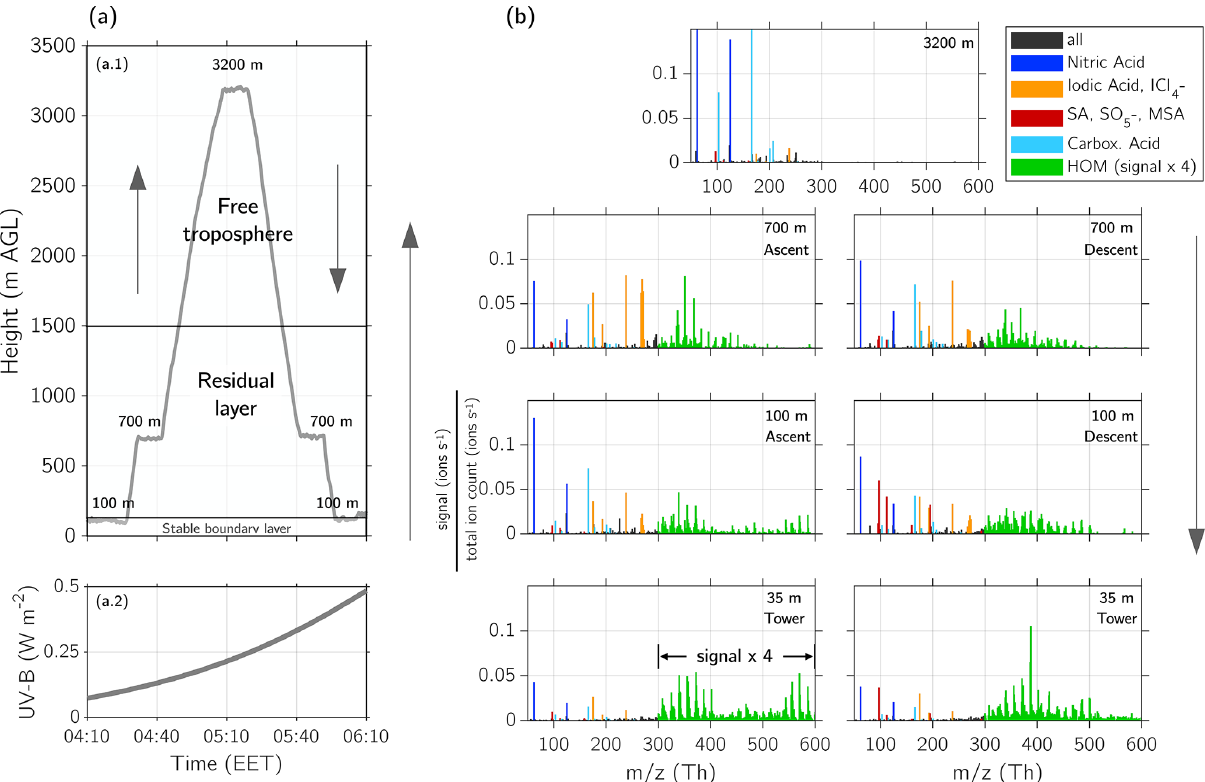
Figure 6. Vertical profile of ions above Hyytiälä on 2 May 2017 at 04:00–06:00EET. (a.1) Height profile of the flight measurements and indication of the different layers (stable boundary layer (SBL), residual layer (RL), and free troposphere (FT)). (a.2) UV-B radiation measured on the ground at SMEAR II station during the flight. (b) Mass spectra measured with APi-TOF at different heights. The altitude where the mass spectra were measured is indicated in the figures and can be compared with the height profile of panel (a) . The lowest mass spectra show the measurements from the tower at SMEAR II station at 35m height, while the presented data are covering the time period of the lowest level measurements at 100m (04:10–04:20 and 05:55–06:05EET) to be comparable. The signal of the HOM-dominated ions (green) between 300–600Th is multiplied by a factor of 4 to make the pattern more visible. A peak list of the different layers can be found in Table A1. The colour code shows the composition of the compounds: nitric acid (blue), iodic acid and iodine–chlorine (yellow), sulfuric acid (SA), SO − and MSA (red), carboxylic acids (cyan), and HOM-dominated ions 5